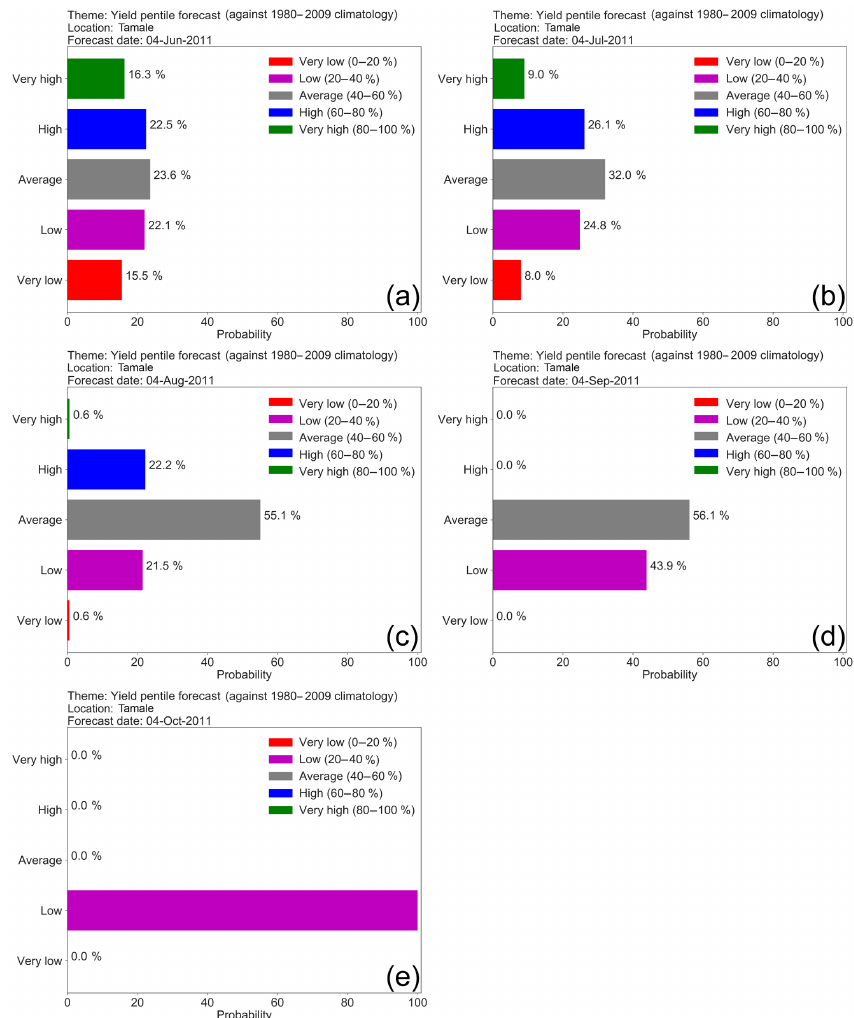
Figure 15. Yield probability forecast for the year 2011 for five forecast dates, (a) 4 June, (b) 4 July, (c) 4 August, (d) 4 September and (e) 4 October, when ensembles are weighted by IRI seasonal forecast average